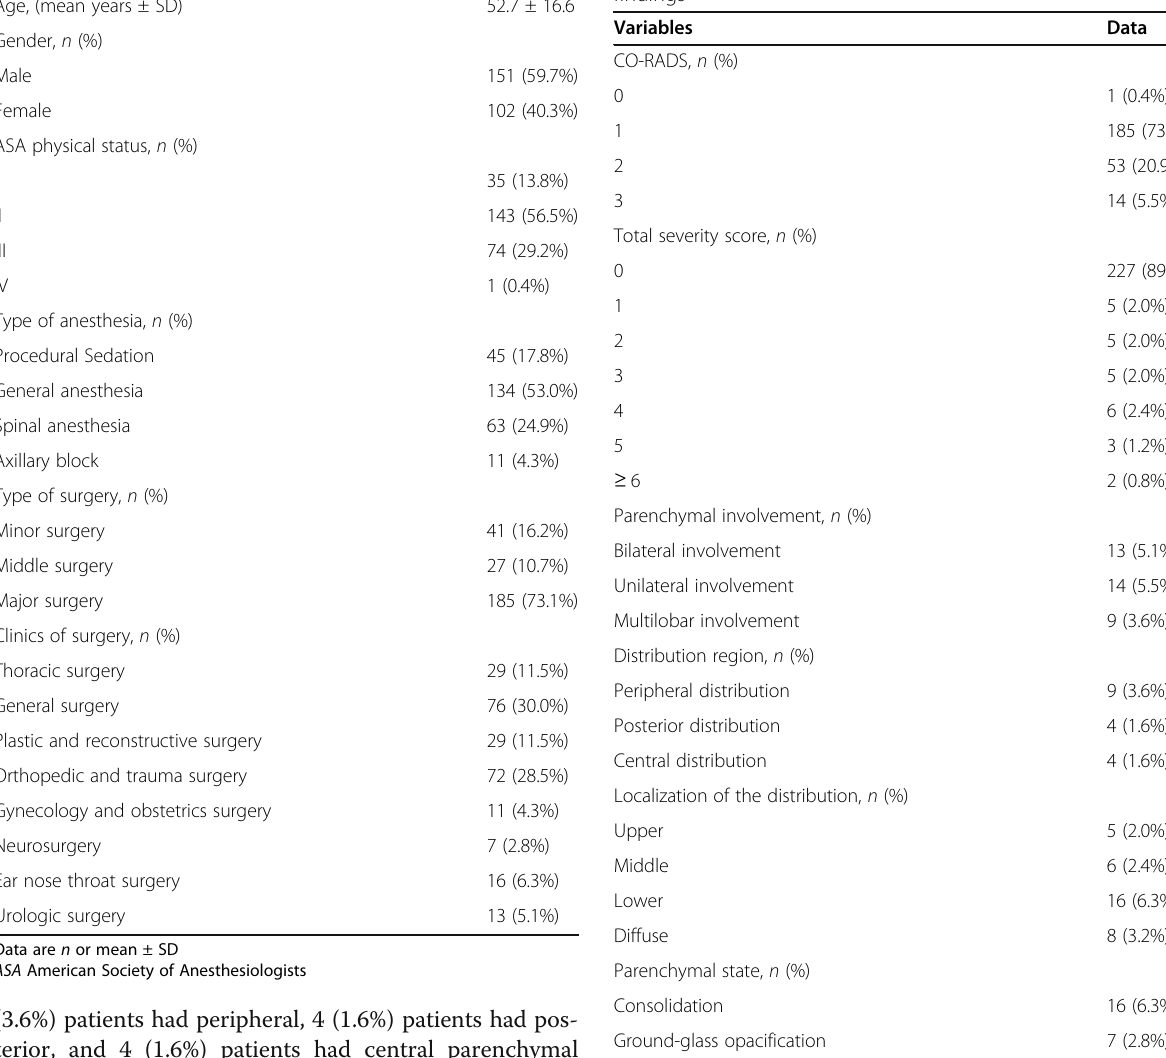
Table 2 Demographic and clinical data of patients Variables